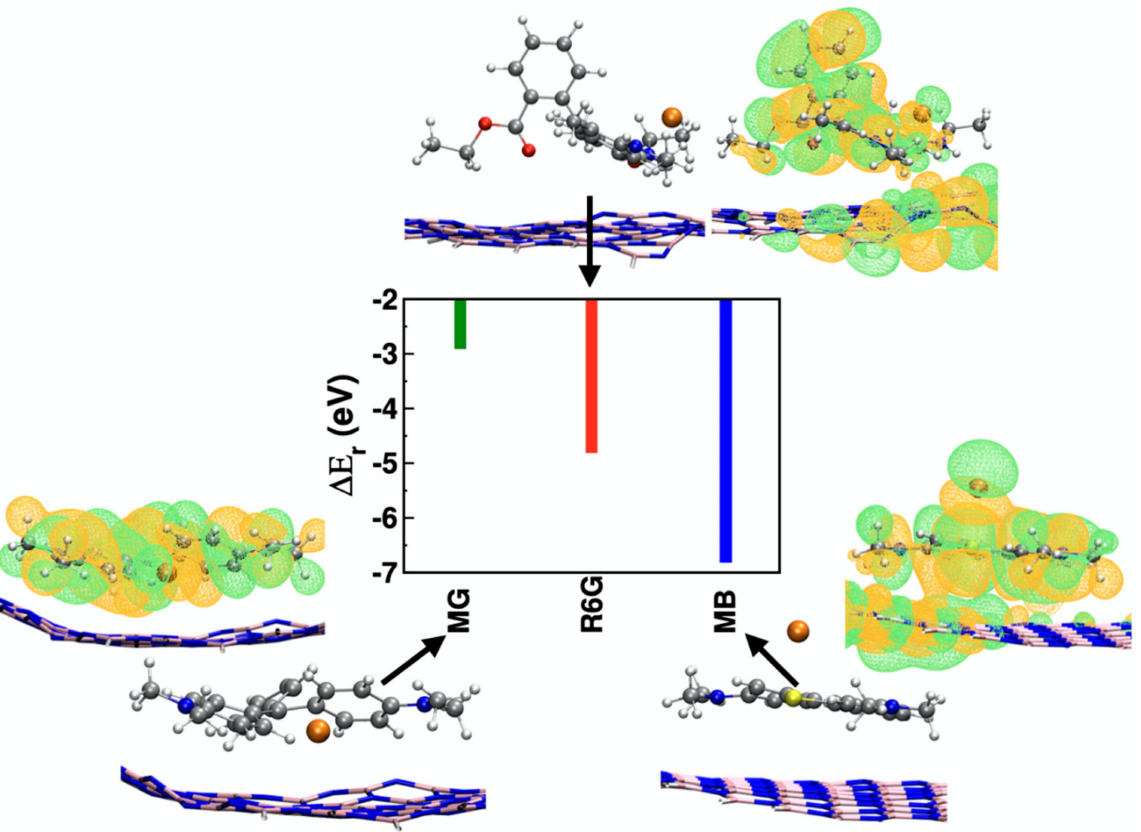
Figure 7. Relative interaction energy, E d between a single layer of hBN and dye molecules that are MB, R6G and MG: methylene blue, rhodamine 6G, and malachite green, respectively. The gray, white blue, pink, crimson, and red colors represent C, H, N, B, Cl, and O atoms, respectively. The HOMO electron density surfaces of the complexes are plotted for an isodensity value of 0.007 a.u. (full view images are available in Figures S10 and